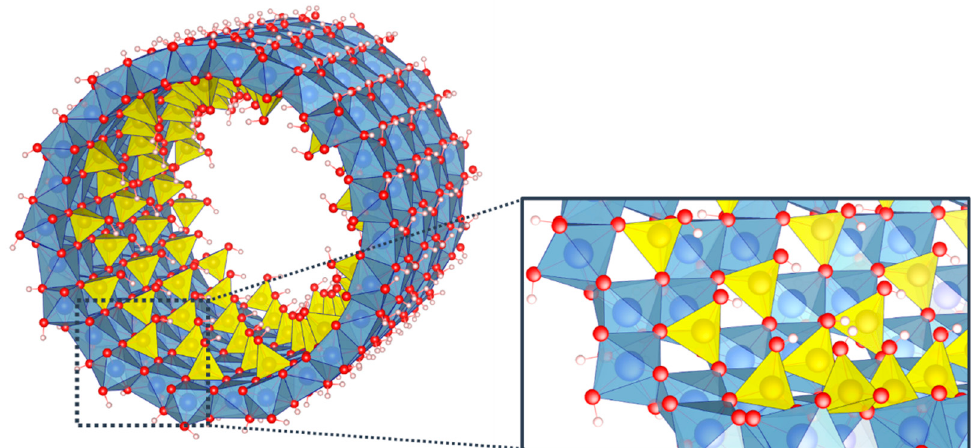
Figure 1. Structure of a single-walled imogolite nanotube and detail of the arrangement of tetrahedron units on the octahedral vacancies. Color code: aluminum (blue); silicon (yellow); oxygen (red); hydrogen (white).